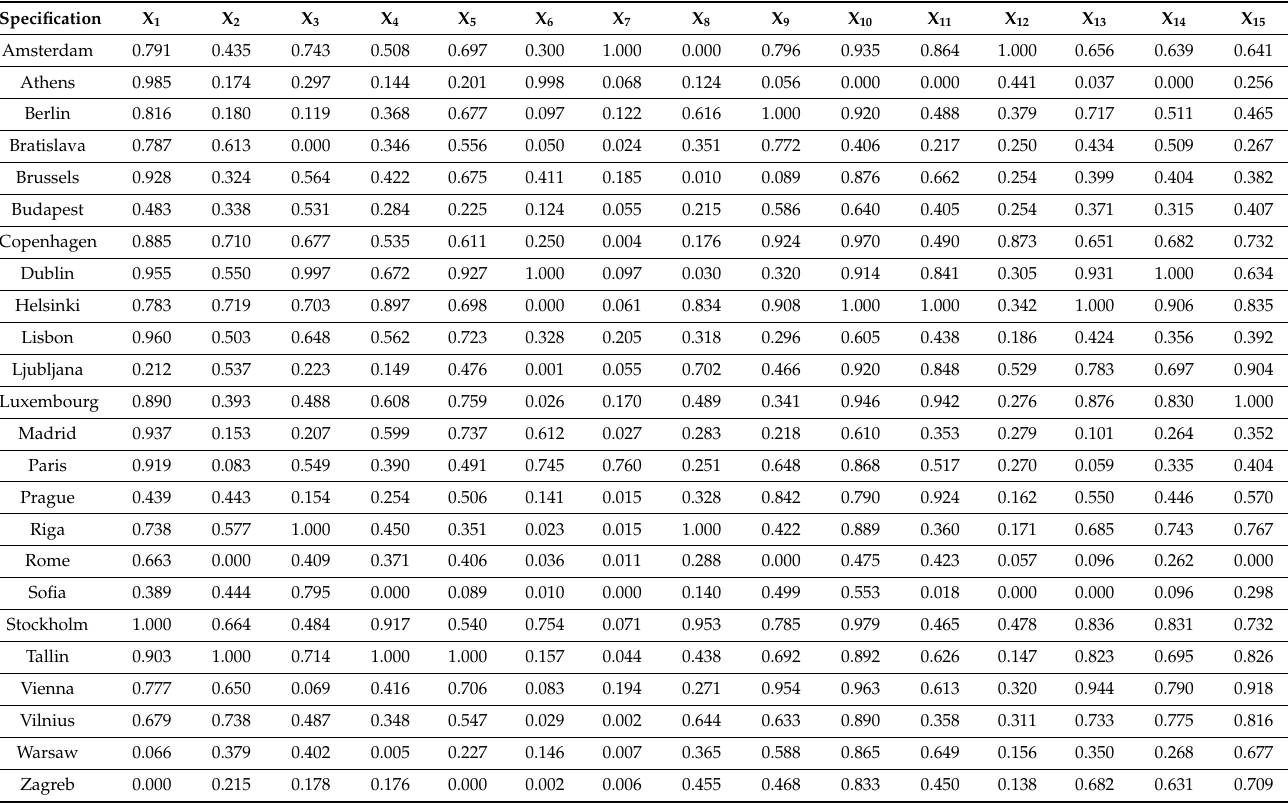
Table A1. Values of standardised diagnostic